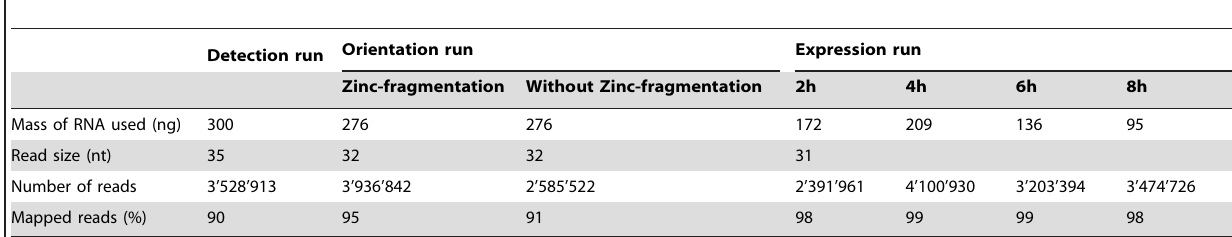
Table 1. Summary of cDNA samples sequenced by Illumina RNA-Seq and mapped on N315 S. aureus